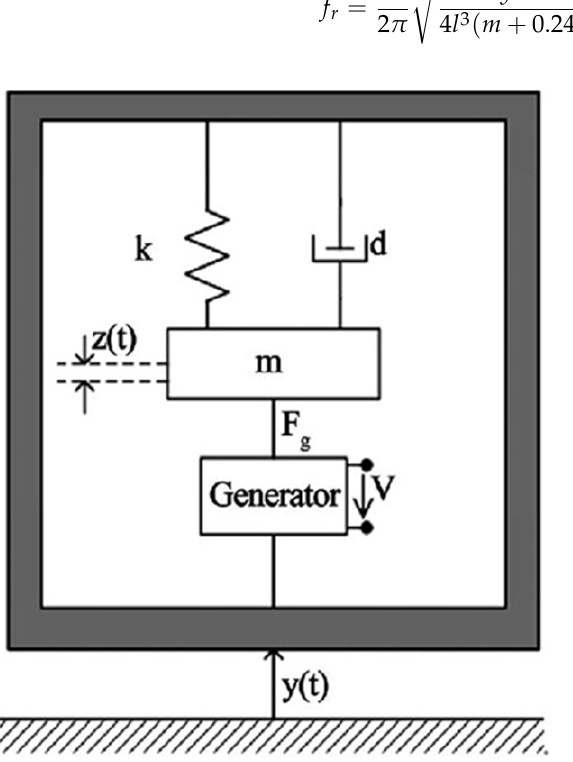
Figure 2. The dynamic model of a vibration-based energy harvester. The resonant frequency tuning methods are categorised into two modes: active or passive. If the tuning mechanism operates periodically and consumes energy only during